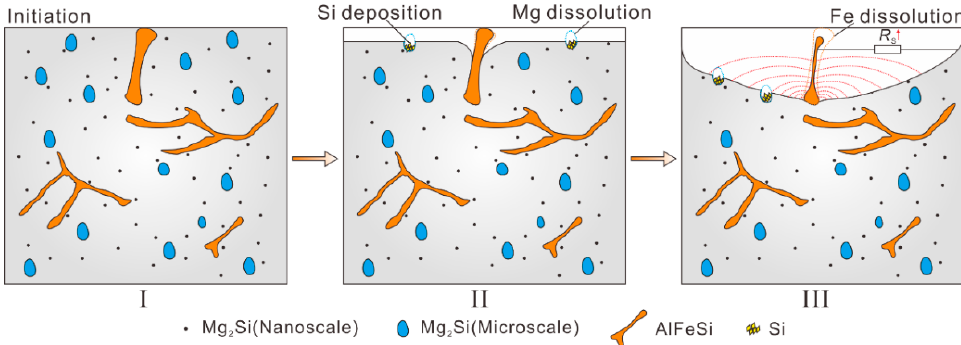
Figure 11. Schematic diagram of the functional mechanism of the AlFeSi phase, microsize Mg 2 Si phase and nanosizeMg 2 Si phase in 6061 aluminium alloy localized corrosion.